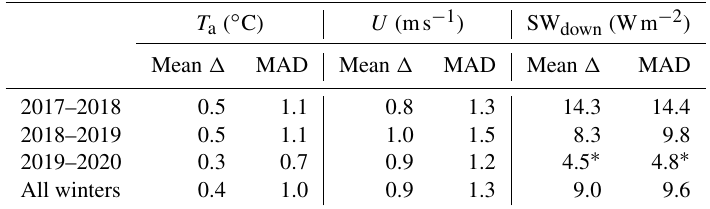
Figure 2. Daily mean (a) air temperature T a , (b) wind speed U , and (c) downwelling shortwave radiation SW down measured at the two sites TUNDRA and FOREST for winter 2018–2019. Labeled tick marks on the x axis indicate the start of each month. Table 1. Mean difference ( (cid:49) ) and mean absolute difference (MAD) between the TUNDRA and the FOREST sites of the air temperature T a , wind speed U , and downwelling shortwave radiation SW down for three winters 2017–2018, 2018–2019, and 2019–2020. Note that the radiation at TUNDRA was replaced with FOREST data for parts of winter 2019–2020 (15 December to 1 March) due to problems with the instrument at